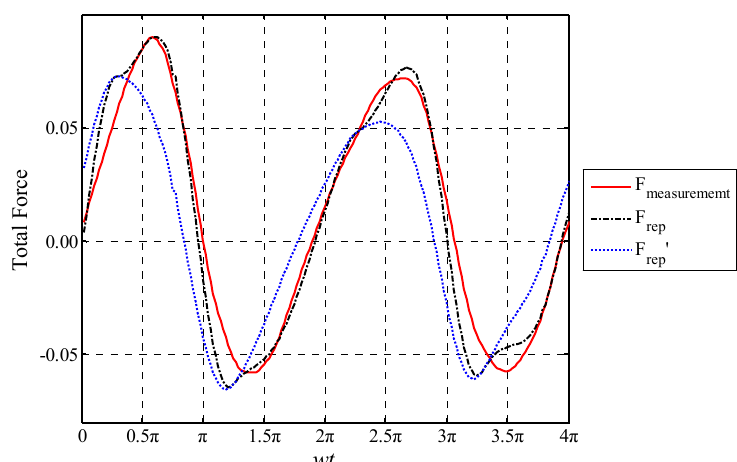
Figure 9. Comparison between reproduced total acting force and measured total force. The red solid line is the measured total force; The black dash line is quantified by using derived period-averaged C D in Equation (1) (i.e., F rep ); The blue dash line is quantified by using C D = 1 in Equation (1) for reference (i.e., F rep ’ ). The shown test case is wave0712, with 7 cm wave height and 1.2 s wave period.